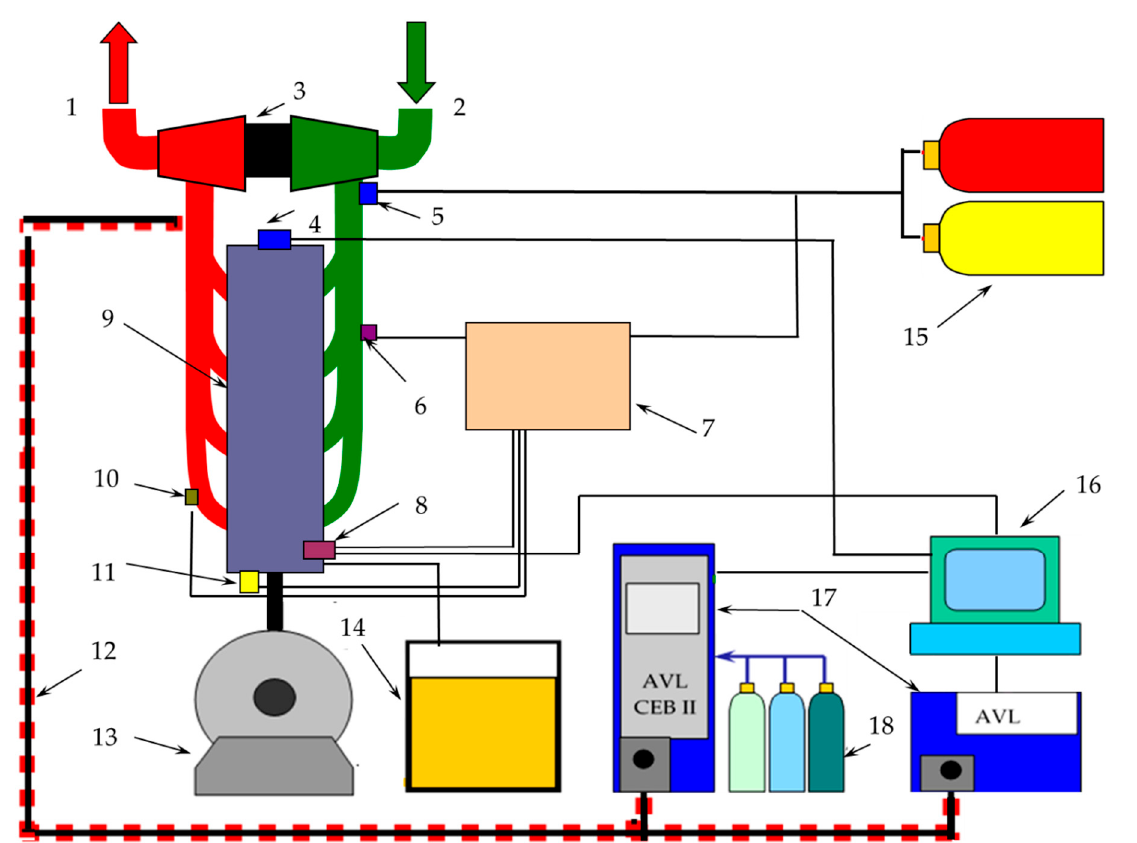
Figure 2. Scheme of the test bench, where: 1—exhaust outlet, 2—air inlet, 3—turbocharger, 4—crankshaft angle sensor, 5—gas fuel injector, 6—boost pressure sensor, 7—fuel electronic dosage control module, 8—cylinder pressure sensor, 9—engine, 10—thermocouple, 11—knocking combustion sensor, 12—heating pipes supplying exhaust gas to the analyzers, 13—AVL electric brake, 14—liquid fuel tank, 15—methane fuel tanks, 16—computer, 17—exhaust gas analyzers, 18—reference gases.